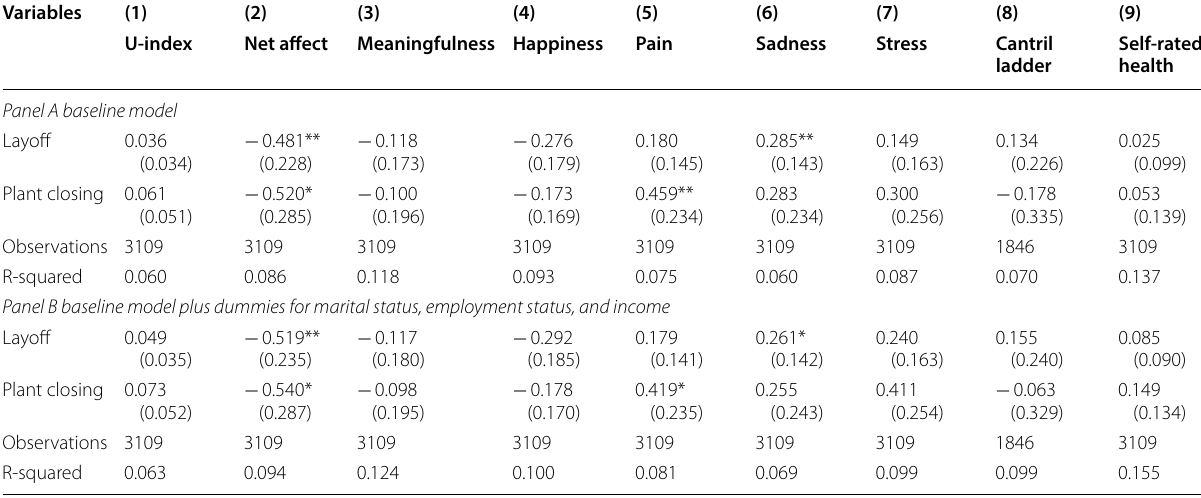
The estimates in columns 1 through 7 and 9 are OLS coefficients from the 2010, 2012, and 2013 ATUS WB Modules; the estimates in column 8 are OLS coefficients from the 2012 and 2013 ATUS WB Modules. All estimates use the WB Module final weight (WUFINLWGT). Standard errors in parentheses. *** p < 0.01, ** p < 0.05, * p < 0.1. The following control variables are included in all columns in both Panels A and B: age and its square; three dummies for race/ethnicity; five education dummies; number of disabilities; an immigrant dummy; number of children; a metropolitan status dummy; two season dummies; year dummies; dummies for the DWS year; and state dummies. Columns 1 through 7 additionally contain a holiday dummy and six dummies for the days of the week. Panel B additionally includes two marital-status dummies; two employment-status dummies; and four dummies for family income during the last 12 months